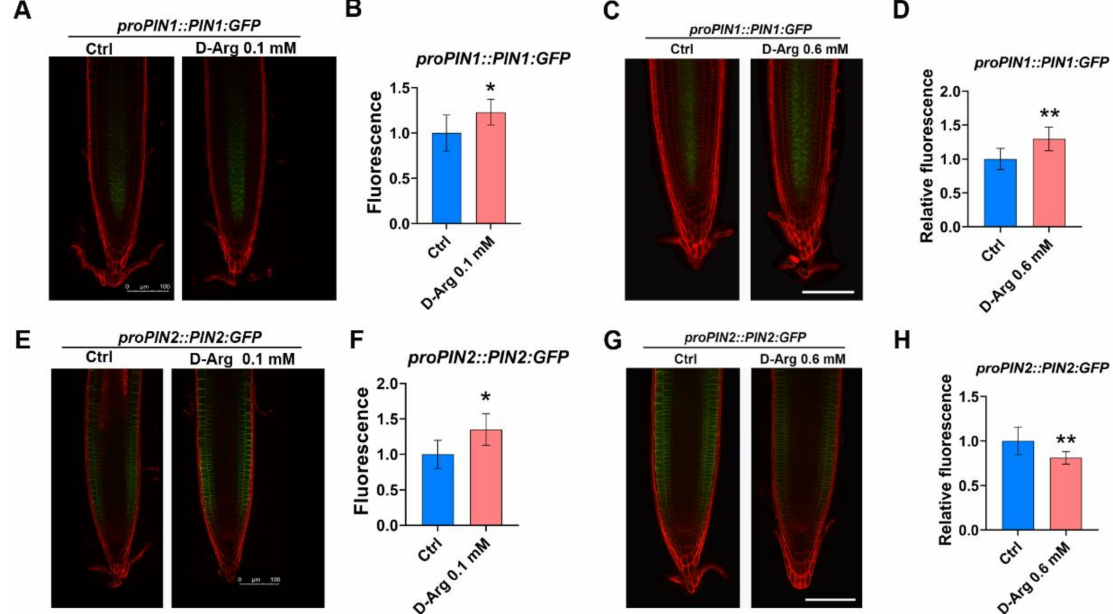
Figure 7. D-Arg treatment differentially affects PIN1 and PIN2 auxin efflux carriers. Five-day-old seedlings at the same devel- opmental stage were transferred to new media containing water (Ctrl) or 0.6 mM D-Arg and treated for 3 days. ( A , B ) Confocal imaging of proPIN1::PIN1:GFP reporter line and relative proPIN1::PIN1:GFP fluorescence indicate that low D-Arg treatment increases PIN1 protein. ( C , D ) proPIN1::PIN1:GFP reporter line and relative proPIN1::PIN1:GFP fluorescence indicate that high D-Arg treatment increases PIN1. ( E , F ) proPIN2::PIN2:GFP reporter line and relative proPIN2::PIN2:GFP fluorescence indicate that low D-Arg treatment increases PIN2 protein. ( G , H ) proPIN2::PIN2:GFP reporter line and relative proPIN2::PIN2:GFP fluorescence indicate that high D-Arg treatment reduces PIN2 protein. All scale bars =100 µ m. Data shown are averages ± SD (n > 15). Asterisks indicate significant differences compared with the control (* p < 0.05, ** p < 0.01; Student’s t